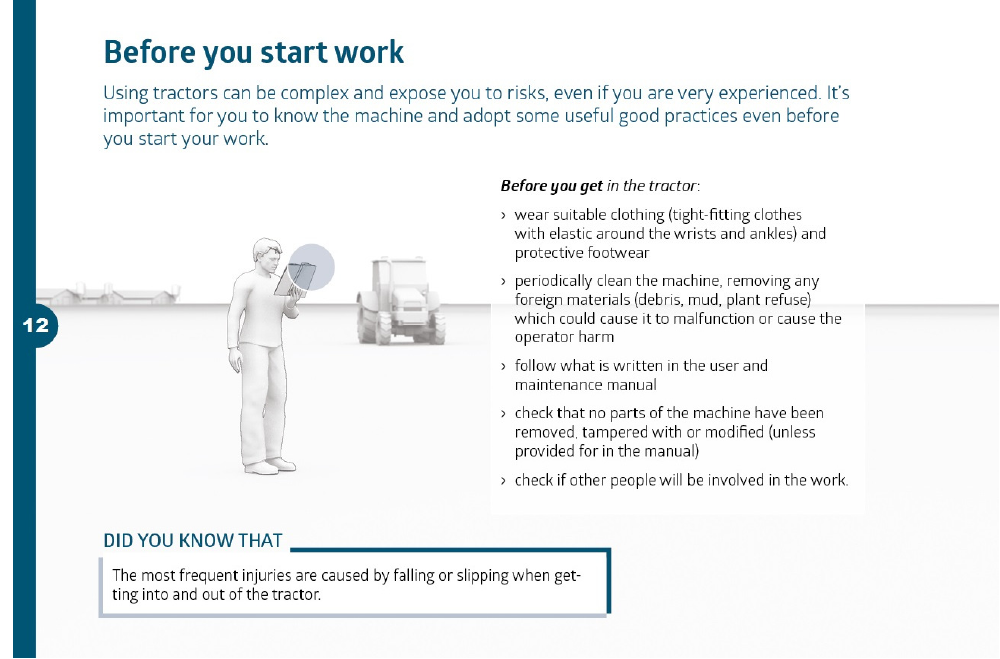
Figure 10. Example of a short sentence introducing every topic in the manual reports.